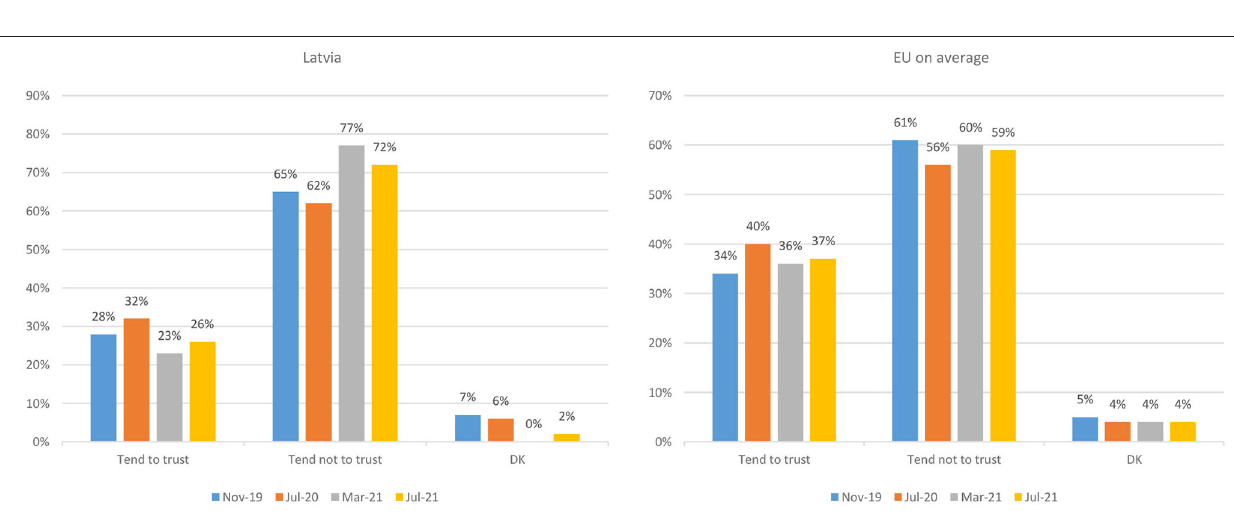
and easier to handle with. Later, during the shortage period of vaccines, the approach of the government for the selection of priority groups was questioned. Upon the arrival of enough